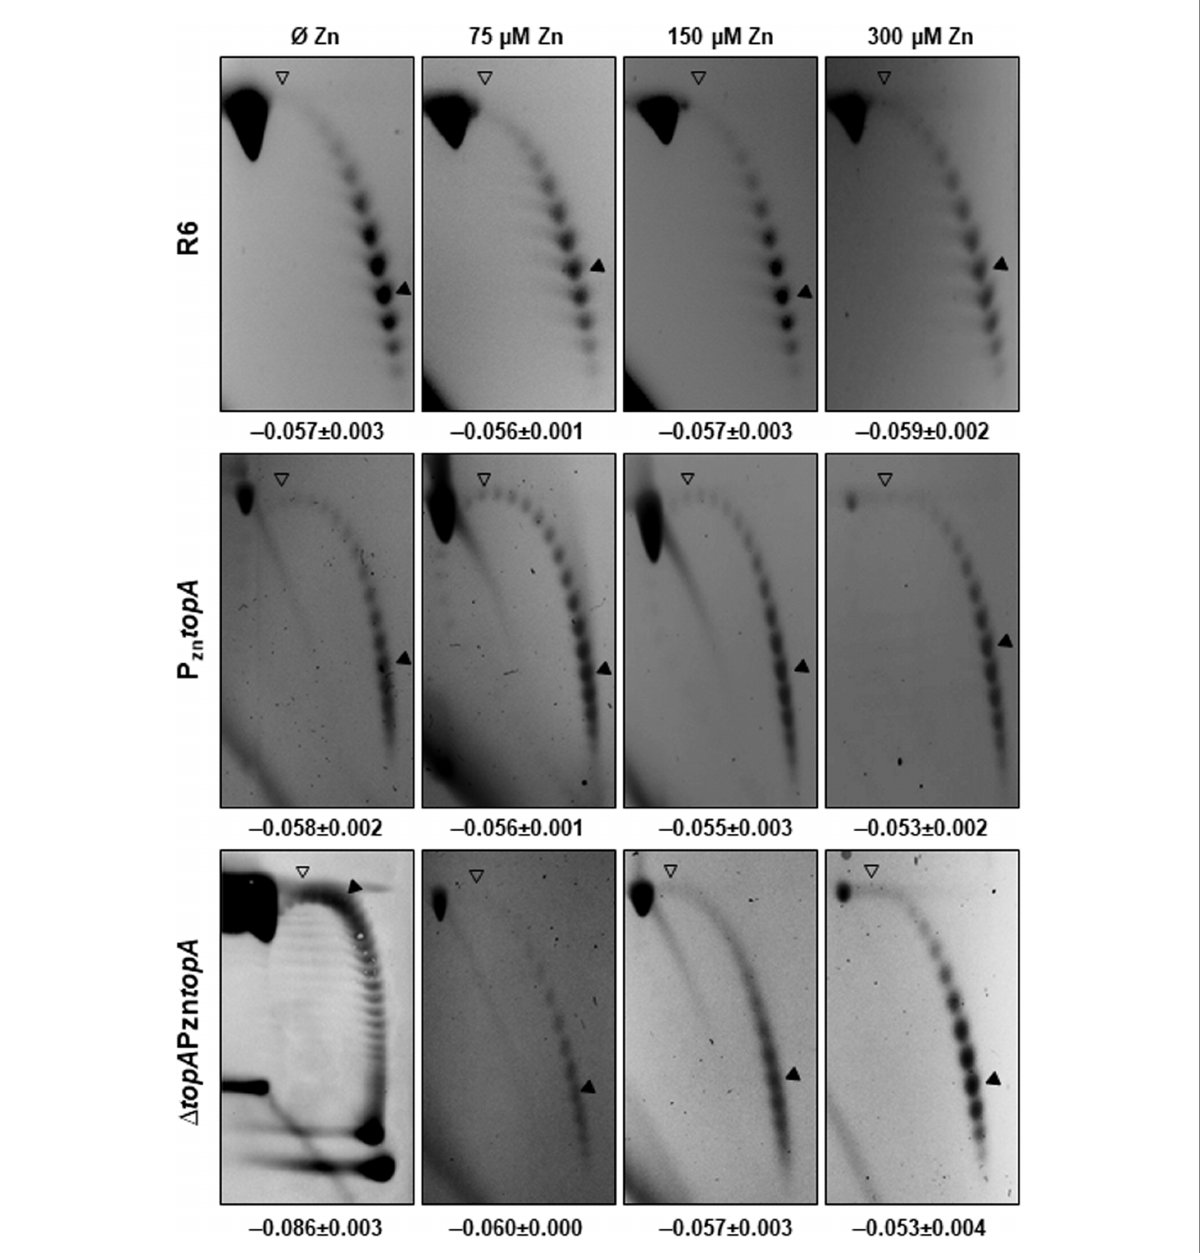
FIGURE 3 pLS1 topoisomers distribution in the diverse ZnSO 4 concentrations in strains R6, P Zn topA and Δ topA P Zn topA . Cultures were grown as in Figure 2. For sample Δ topA P Zn topA 0 ZnSO 4 , 2D-agarose gels were run in the presence of 5 and 15 μ g/ml chloroquine in the first and second dimensions, respectively. For the rest of the samples, 1 and 2 μ g/ml chloroquine were used. An empty arrowhead indicates the topoisomer that migrated with Δ Lk = 0 in the second dimension and has a Δ Wr = − 14 or − 31 during the first dimension (the number of positive supercoils introduced by 2 μ g/ml or 15 μ g/ml chloroquine), respectively. A black arrowhead indicates the most abundant topoisomer. Mean of three independent experiments ± SD are